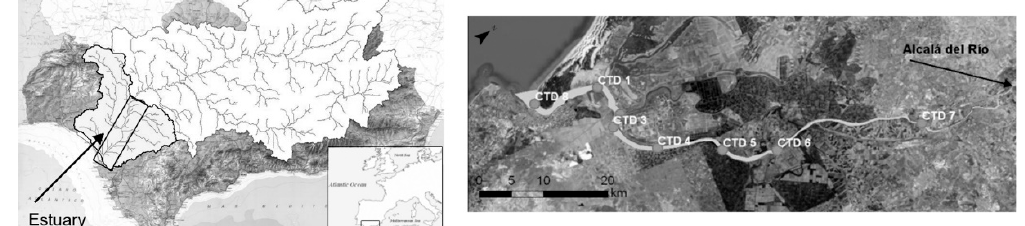
Fig. 1 Location of Guadalquivir River estuary and of the CTD